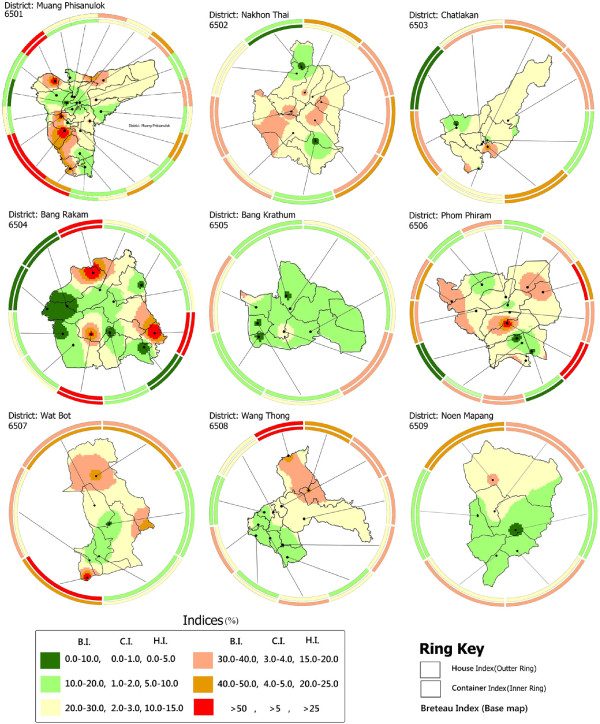
Methodology flow chart.